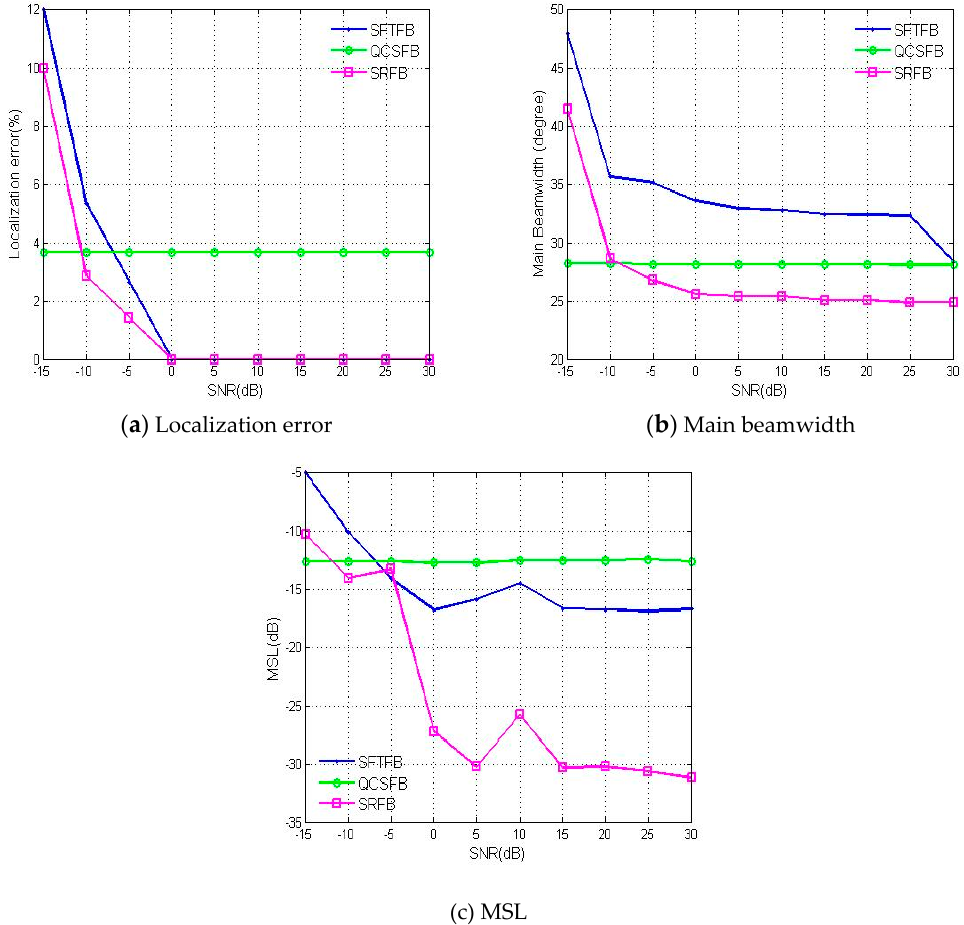
Figure 7. The performance of the three methods investigated based on the ( a ) localization error, ( b ) main beamwidth and ( c ) MSL with respect to the signal to noise ratio (SNR).